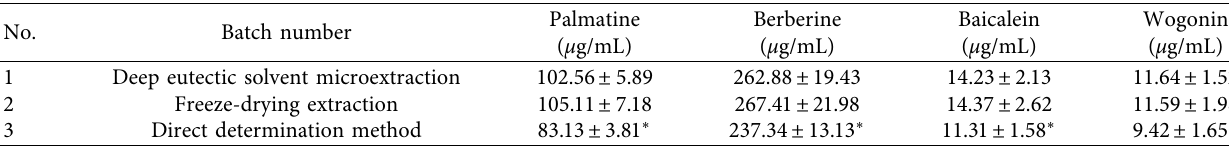
Table 9: Application of the novel method to SD samples ( N � 10).